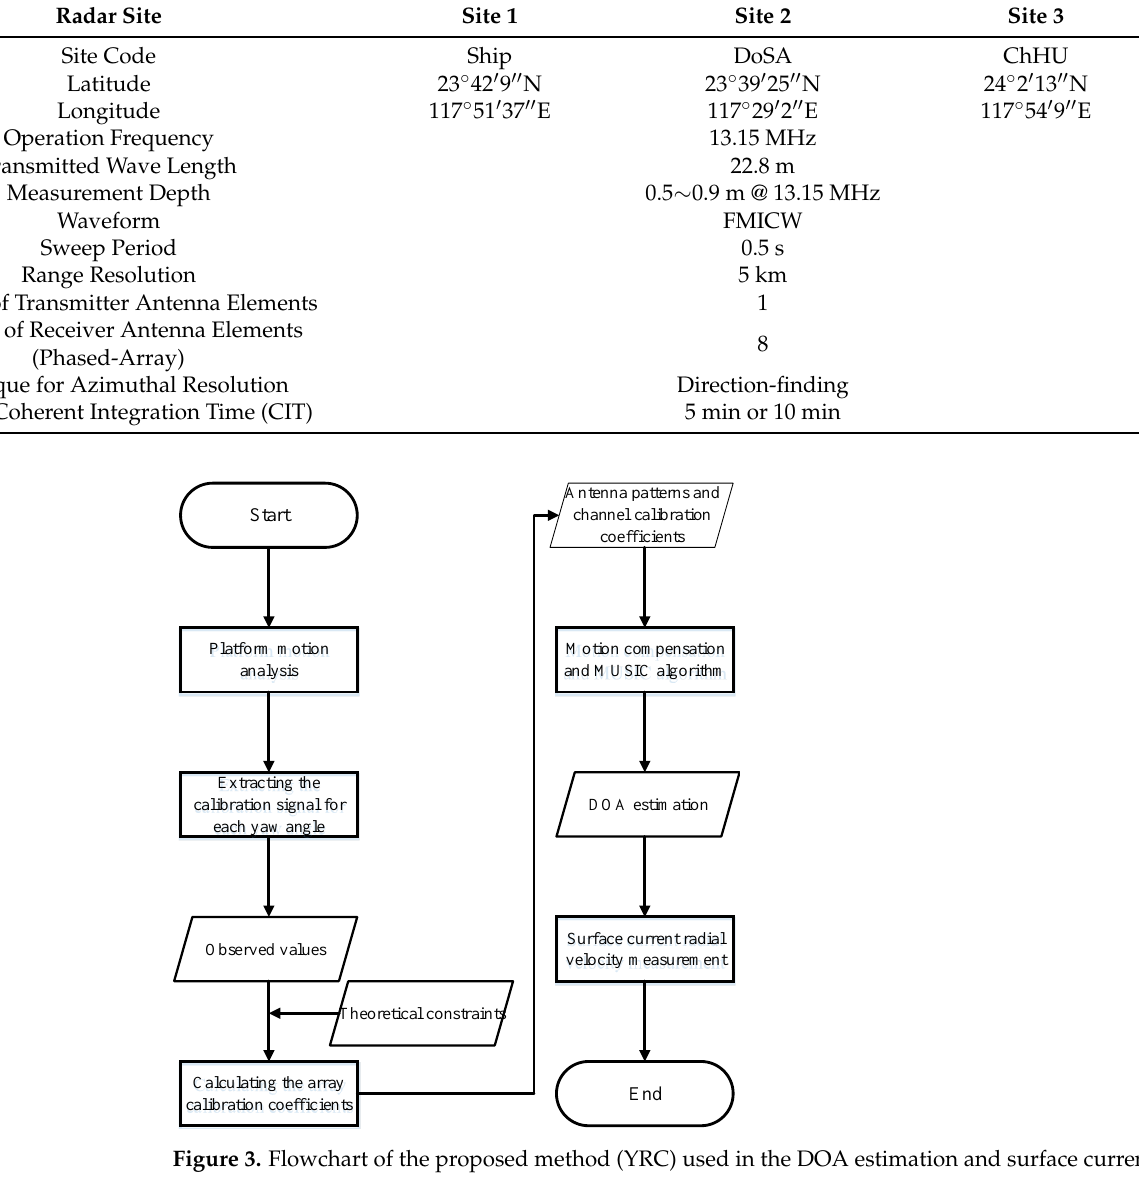
Figure 3. Flowchart of the proposed method (YRC) used in the DOA estimation and surface current measurement, including six main steps: platform motion analysis, extraction of the calibration signal for each yaw angle, calculation of the array calibration coefficients, motion compensation and MUSIC algorithm, DOA estimation, and surface current radial velocity